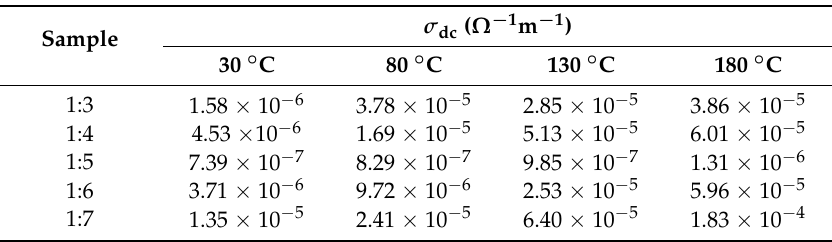
Table 5. Direct current (DC)-like conductivity extracted from the AC conductivity spectrum at different ratios for BaFe 12 O 19 at 1 kHz.